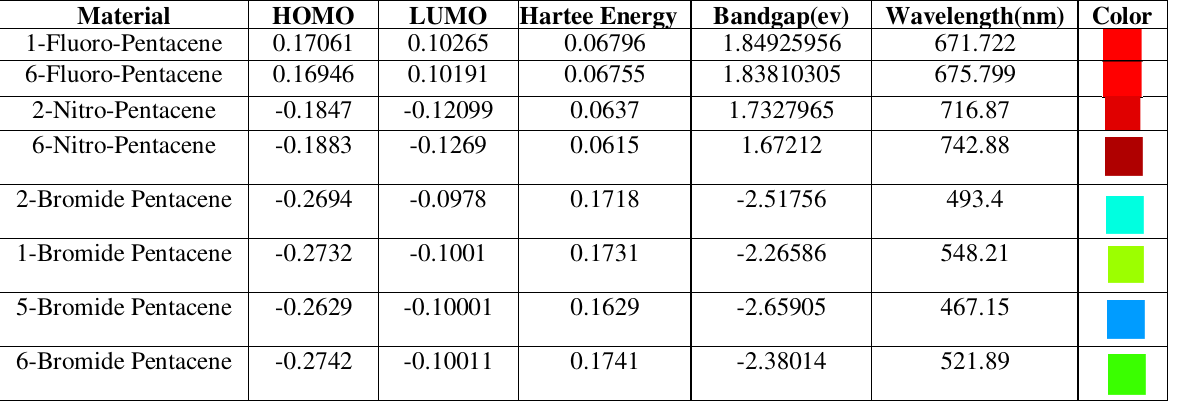
Table 4: Shade comparison of 2-Fluoro-Pentacene, 6-Nitro-Pentacene, and Bromide-Pentacene